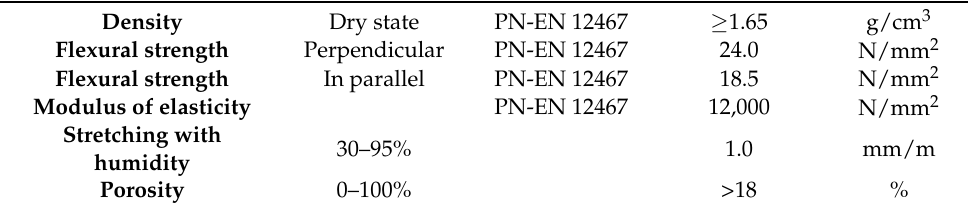
Table 1. The declared technical parameters of the boards. Density Dry state PN-EN